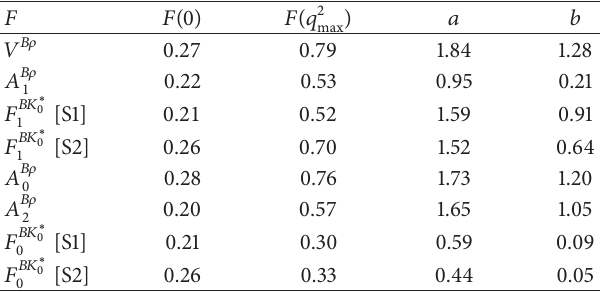
Table 2: Form factors of 𝐵 → 𝜌,𝐾 ∗ 0 (1430) transitions obtained in the covariant light-front model